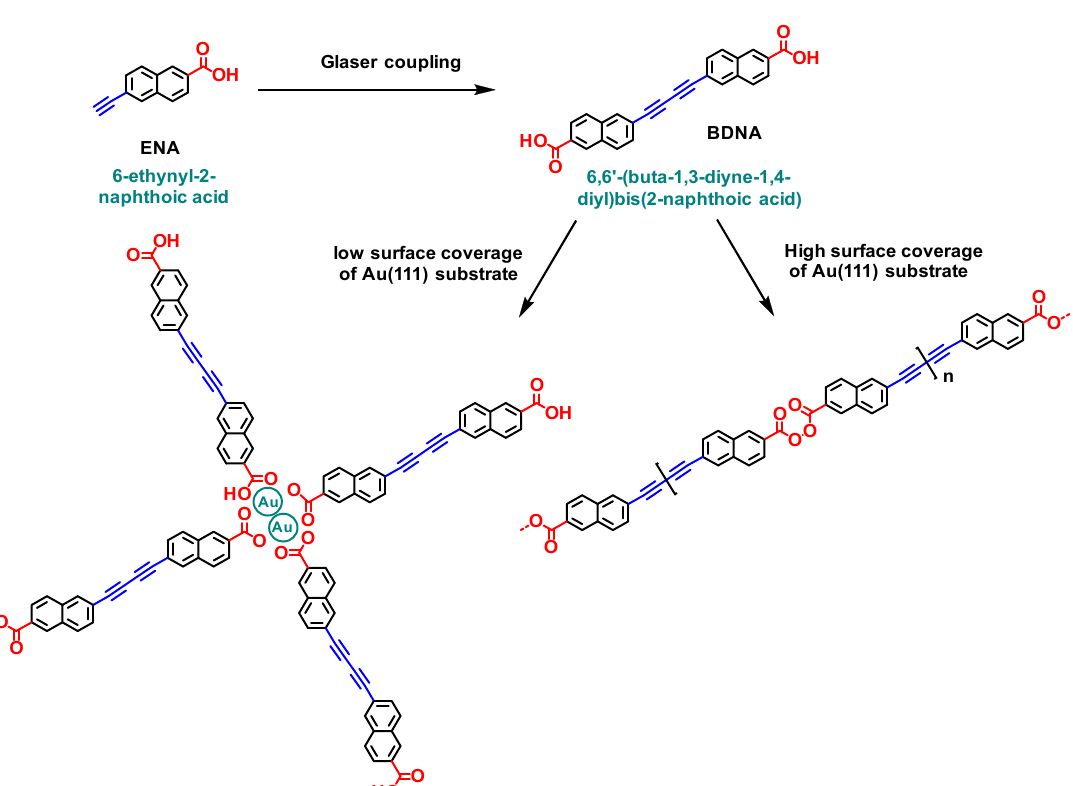
Figure 23. Polymerization of 6-ethynyl-2-naphthoic acid (ENA) by a domino reaction based on the Glaser coupling/dehydrogenative coupling combination. Depending of the density of molecules onto the Au(111) substrates, different structures are obtained.